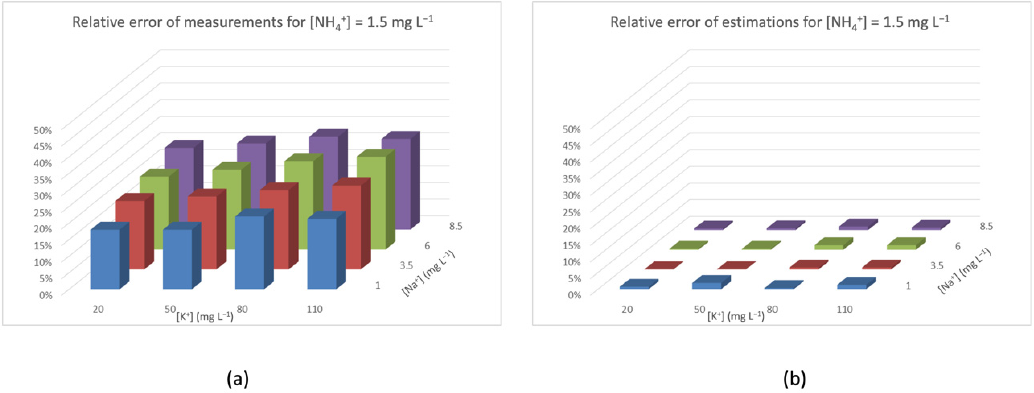
Figure 7. Relative error for [NH 4+ ] = 1.5 mg L − 1 ( a ) measured by the ISE and ( b ) after TMR and interference rejection.